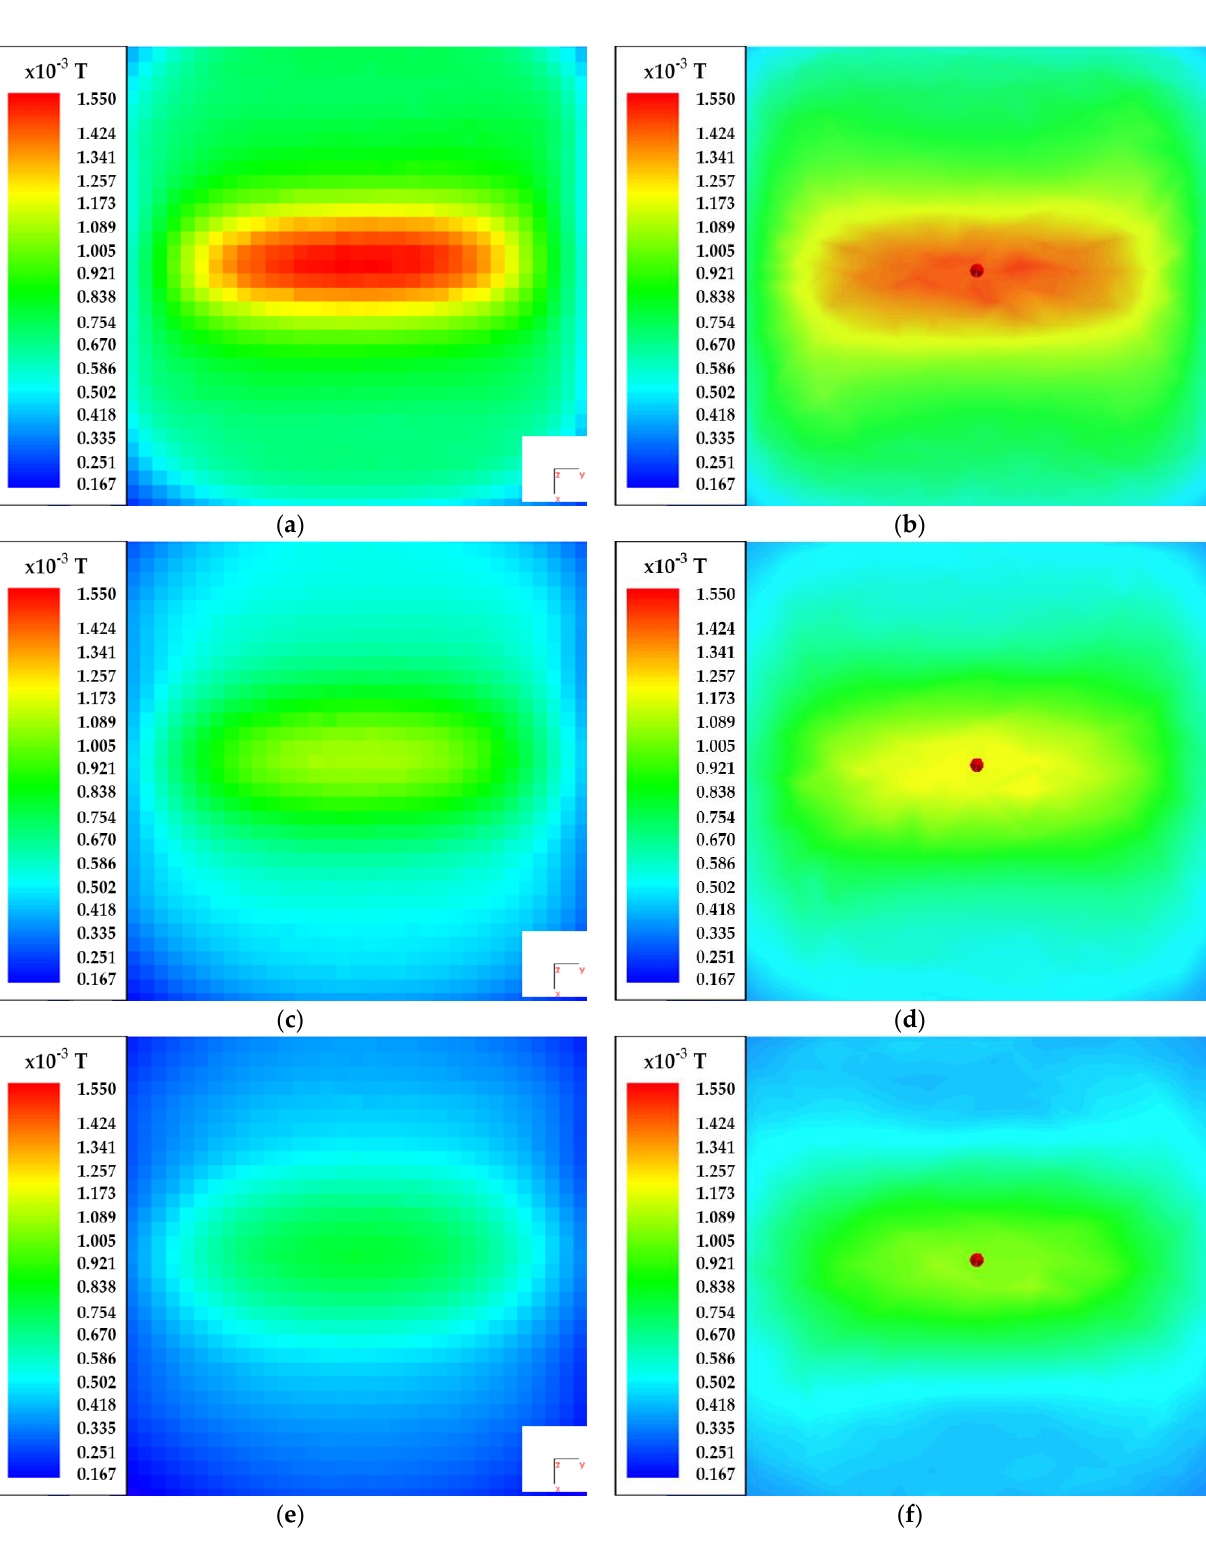
Figure 21. Magnetic flux density measurement of the DD transfer pad: ( a ) measured absolute value of magnetic flux density at z = 15 mm; ( b ) simulated absolute value of magnetic flux density at z = 15 mm; ( c ) measured absolute value of magnetic flux density at z = 20 mm; ( d ) simulated absolute value of magnetic flux density at z = 20 mm; ( e ) measured absolute value of magnetic flux density at z = 25 mm; ( f ) simulated absolute value of magnetic flux density at z = 25 mm.